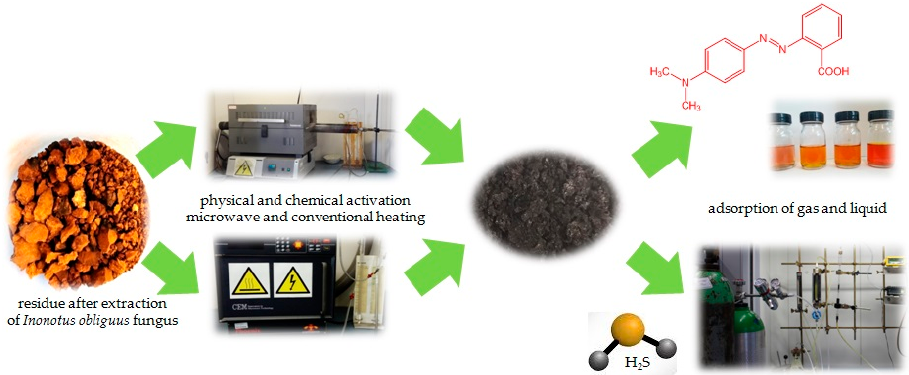
Figure 1. Scheme of the biocarbons